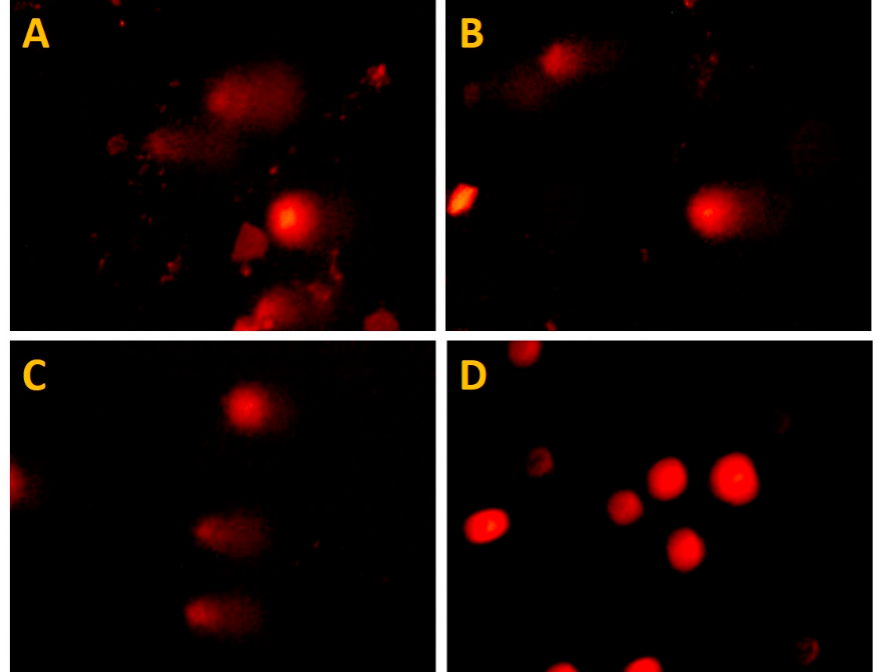
Figure 5. Induced comets by exposure of RL14 cardiomyocytes to the treatments: PPNPs ( A ), NSC ( B ), PAPESE ( C ), and negative control ( D